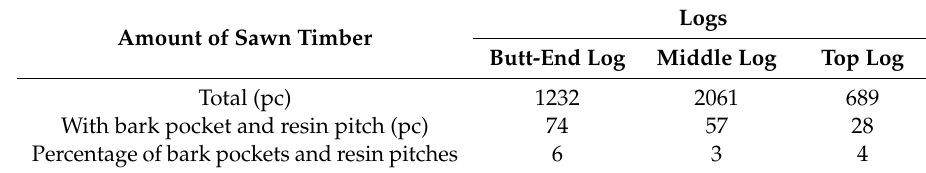
Table 8. The percentage of bark pockets and resin pitches as a factor a ff ecting the quality class of sawn timber in the longitudinal section of long logs.